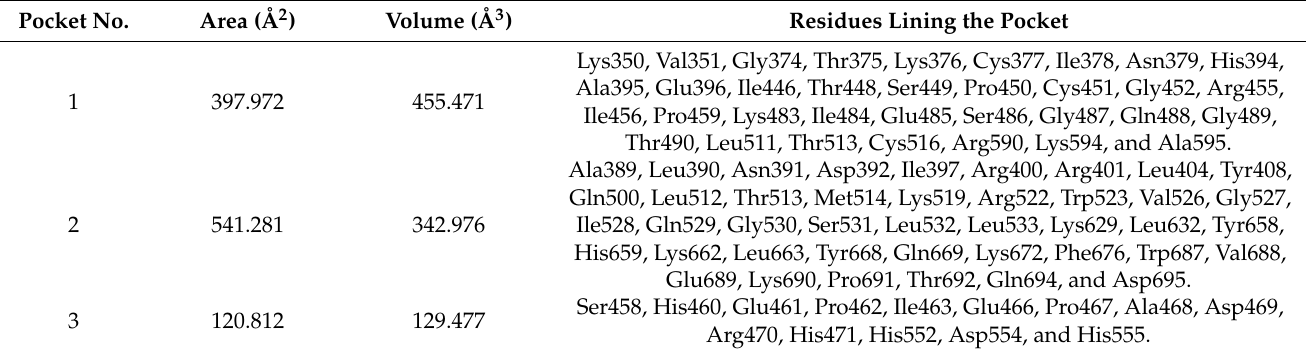
Table 1. Predicted binding cavities via CASTp with their area, volumes and residues lining each pockets. Pocket